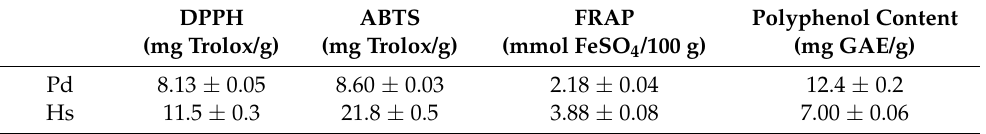
Table 2. Antioxidant properties and polyphenol content of Pd and Hs methanolic extracts. DPPH ABTS FRAP (mg Trolox/g) (mg Trolox/g) (mmol FeSO 4 /100 g) Pd